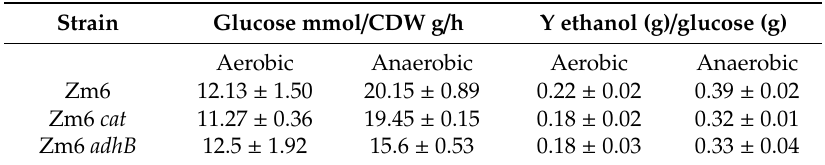
Figure 1. A schematic overview of central carbon metabolism in Z. mobilis , coloured by log2 heatmap of intracellular metabolites concentration in aerobically growing to aerobically resting Zm6 cells (left) and anaerobic to aerobic resting Zm6 cells (right). Table 1. Steady state glucose consumption rate (glucose mmol / cell dry weight g / h) and ethanol yield (g) per glucose (g) during resting cultivations. Each value is a mean of three technical replicates with a standard deviation.